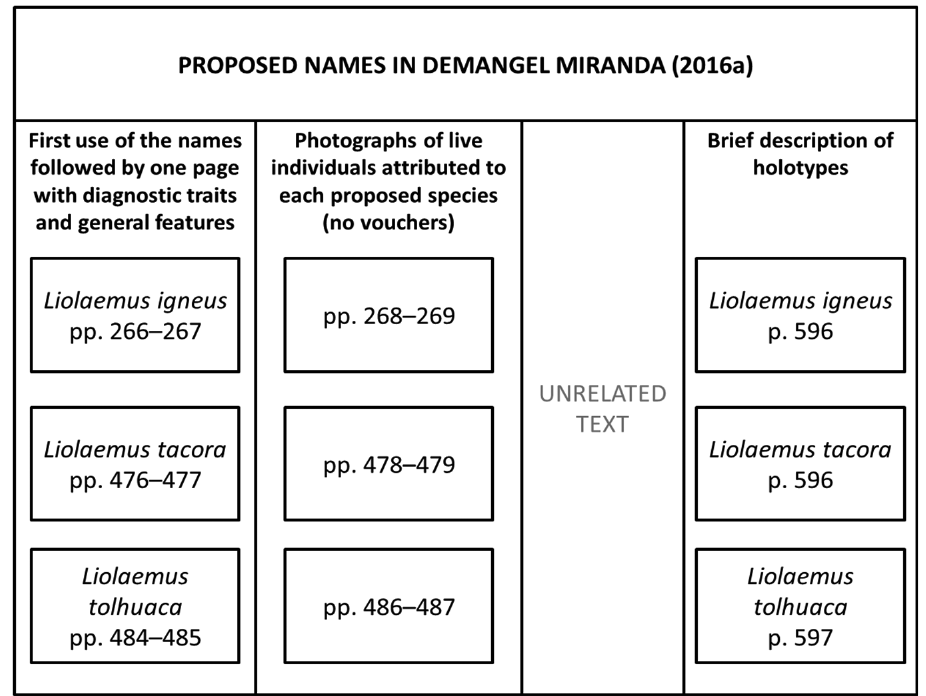
Figure 1. Outline of the non-standard presentation of the three species proposed by Demangel Mi- randa